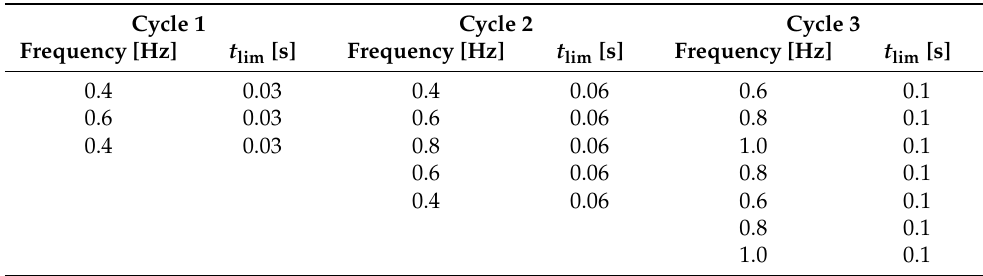
Table 3. Cyclic frequency bands and time